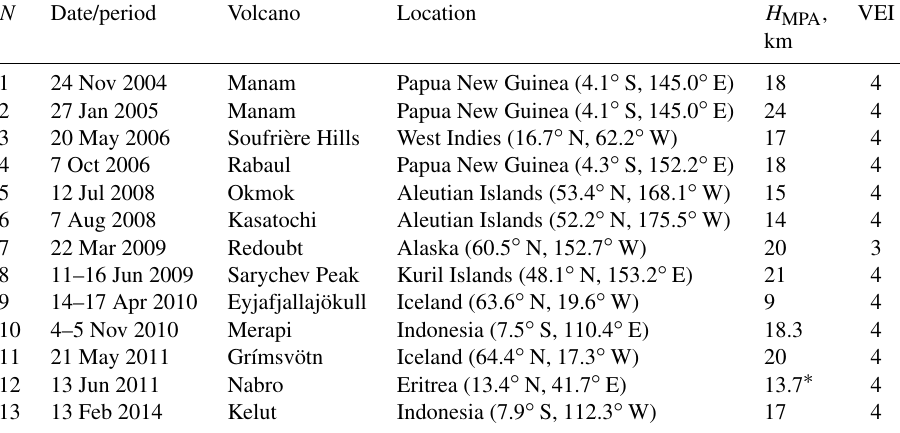
Table 3. List of volcanic eruptions that have perturbed the UTLS over Tomsk from 2004 to the present day. The list was retrieved from the GVP data. N